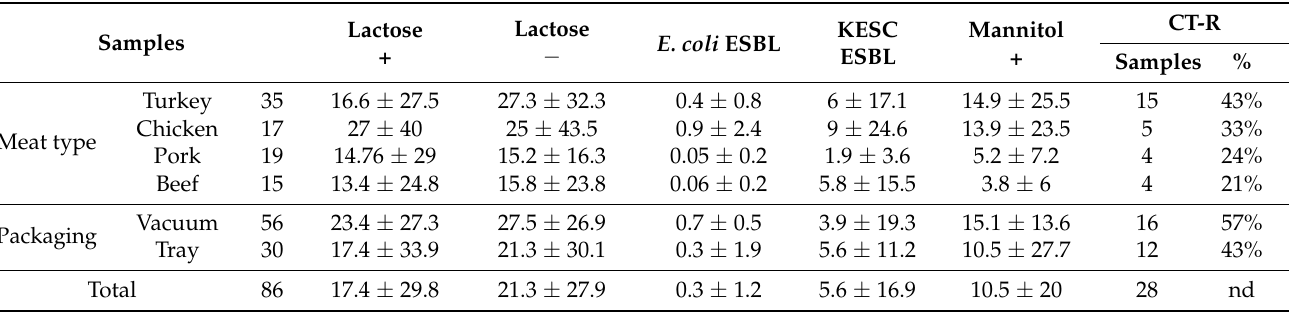
Table 2. Overview of the microbial abundance on different meat samples collected in Gdansk, Poland, 2020. The results are expressed as mean CFU/cm 2 of the tested meat with standard deviation. Lactose utilization was tested on MacConkey media, while mannitol utilization was tested on MSA media. The ESBL strains were enumerated on ChromAgar ESBL media.